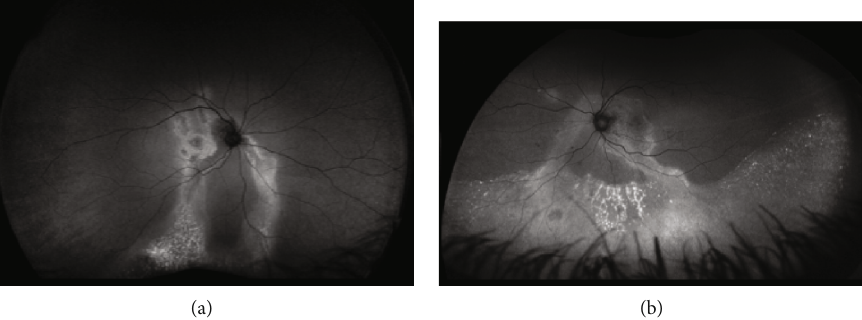
Figure 3: Fundus auto fl uorescence of two di ff erent patients with chronic central serous chorioretinopathy with descending tracts or “ guttering ” .